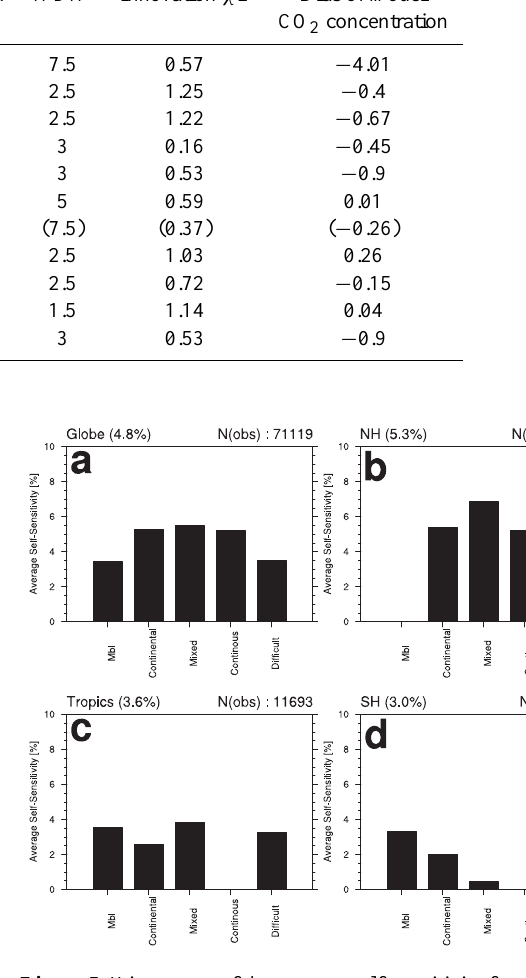
Figure 5. Histograms of the average self-sensitivity for each obser- vation site category from 2001 to 2009 (a) around the globe and in the (b) Northern Hemisphere, (c) tropics, and (d) Southern Hemi- sphere. N(obs) in the upper right corner represents the number of observations used in data